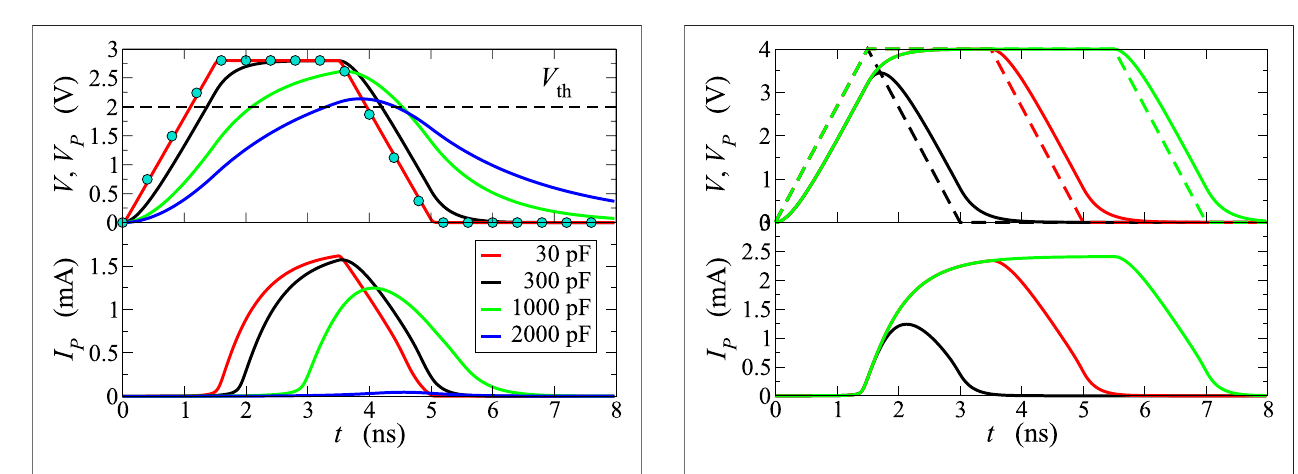
FIGURE 9 | Simulated voltage drop V P (above) and current I P (below) of the PCM. The input signal V (above, circles) has a trapezoidal form with a plateau at 2.8 V, and is applied through the circuit of Figure 1 with R L = R S = 1 Ω . Capacitance C is given different values as shown in the fi gure. The horizontal, dashed line marks the threshold voltage V th .